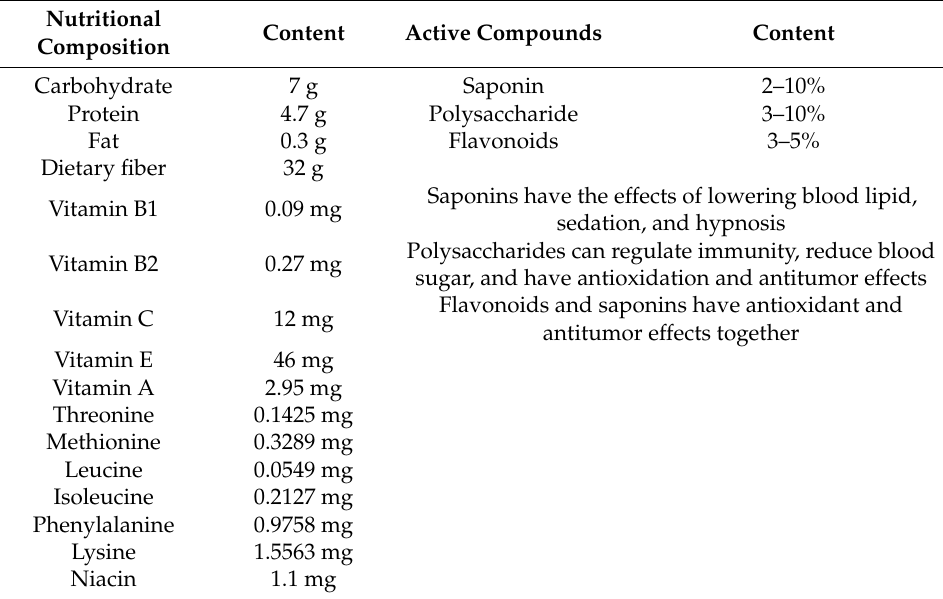
Table 1. Nutritional value and active compounds of Gynostemma pentaphyllum